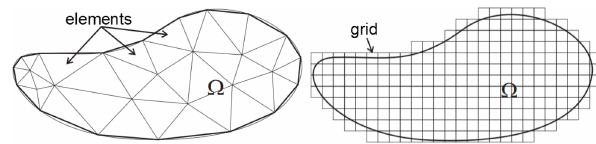
Figure 8. The irregular geometrical structure of the mesh allows capturing information in a more efficient way than regular grids by following the properties of the underlying system (figure taken from Ferreira et al.,